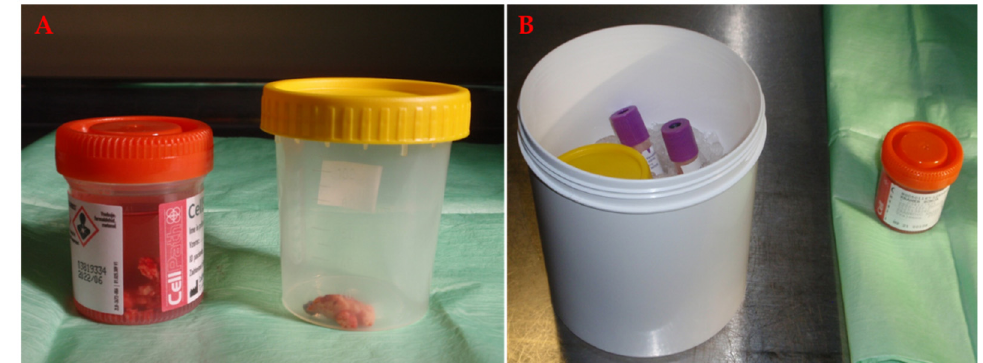
Figure 3. ( A ) Glioblastoma tissue specimen prepared for transport to the cell laboratory for cell isolation and pathology for histopathological evaluation. The sample destined for pathology is preserved in formaldehyde solution (left), and the tissue for the cell laboratory is transported in saline (right). ( B ) The goal is to transport the tissue on ice and as quickly as possible to reduce cell death.